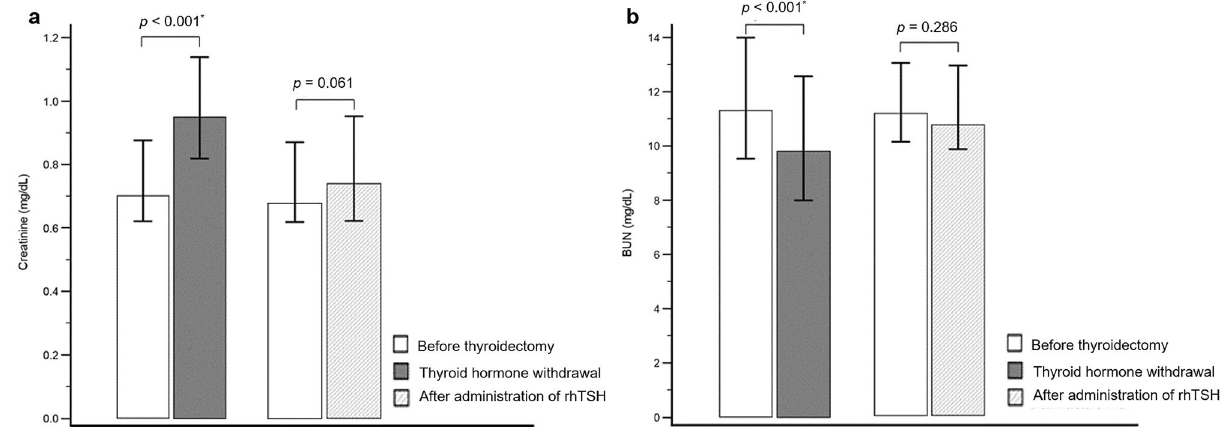
Figure 1. Effects of THW or rhTSH administration on renal parameters. ( a ) The Cr level was significantly higher after THW than before thyroidectomy ( p < 0.001). However, there was no significant difference in the Cr level after rhTSH administration compared to that before thyroidectomy ( p = 0.061). ( b ) When thyroid hormone therapy was discontinued, BUN was significantly decreased from levels observed prior to thyroidectomy ( p < 0.001). The administration of rhTSH did not affect the BUN level ( p = 0.286). BUN blood urea nitrogen, Cr creatinine, rhTSH recombinant human thyroid-stimulating hormone, THW thyroid hormone